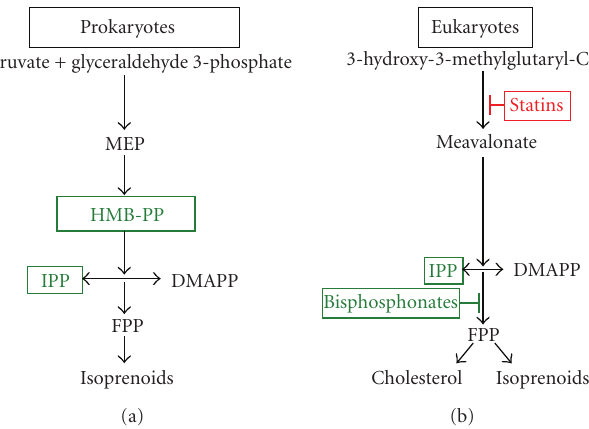
Figure 2: Human V γ 2V δ 2 T cells respond to stimulatory phosphoantigens produced during bacterial or mammalian isoprenoid synthesis. Isoprenoid synthesis in many prokaryotes and protists produces the intermediate ( E )-4-Hydroxy-3-methyl-but-2-enyl pyrophosphate (HMBPP) from pyruvate and glyceraldehyde 3-phosphate via the erythritol 4 phosphate pathway. Eukaryotes use the mevalonate pathway that produces isoprenoids and colesterol. HMBPP and IPP are phosphoantigens; HMBPP is unique to the erythritol 4 phosphate pathway while IPP is produced in both pathways. Phosphoantigens stimulate cytokine secretion and cytotoxicity in human V γ 2V δ 2 T cells. Statins block the eukaryotic pathway prior to mevalonate synthesis, and decrease the production of IPP. Bisphosphonates are a class of drugs that inhibit farnesyl pyrophosphate synthase and cause the accumulation of IPP in mammalian cells. When mammalian cells of myeloid origin and some tumor cells are treated with bisphosphonate, they are more stimulatory for V γ 2V δ 2 T cells due to increased IPP